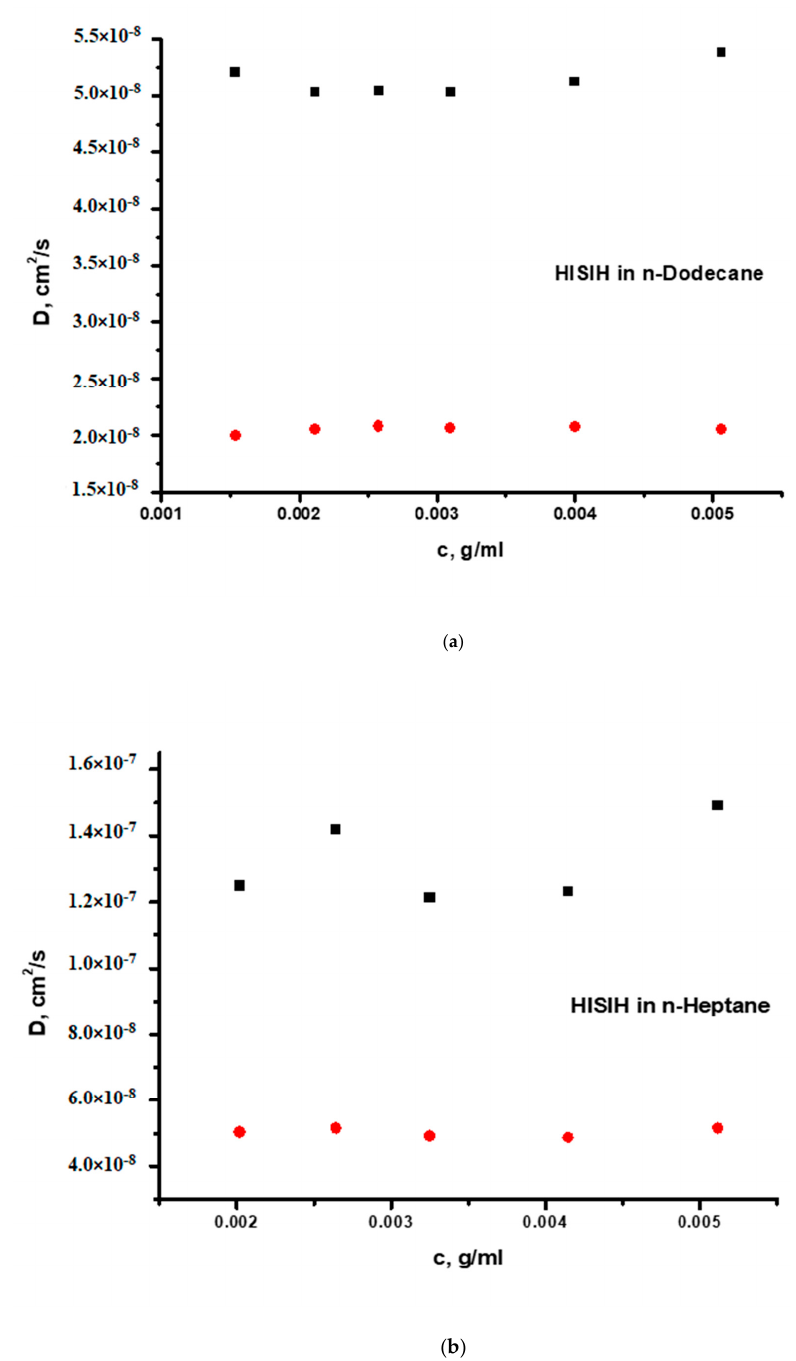
Figure 5. ( a ) DLS plots of the two populations of the HISIH pentablock terpolymer in n-dodecane and ( b ) DLS plots of the two populations of the HISIH pentablock terpolymer in n-heptane.